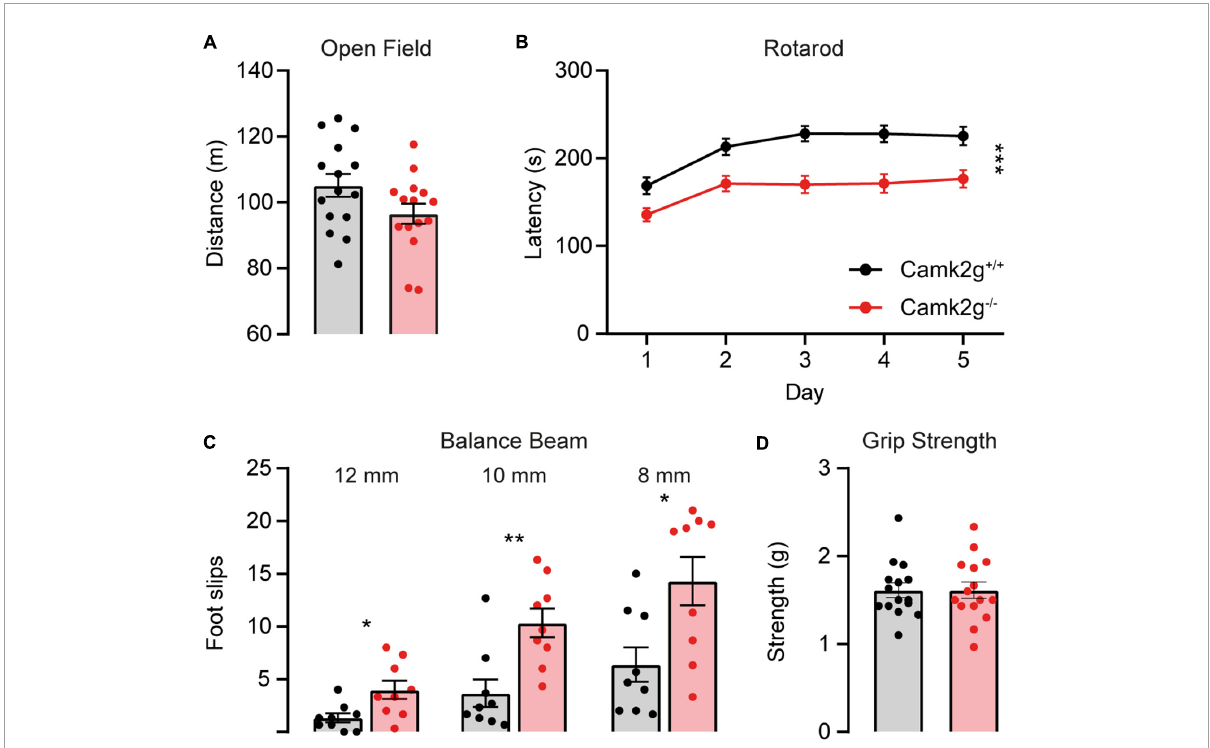
FIGURE4 CAMK2G in motor behavior. (A) No differences were found in the distance traveled in the open field [unpaired t -test, t ( 28 ) = 1.85, p = 0.076; n = 15]. (B) Camk2g − / − mice showed reduced latency to fall of the accelerating rotarod [two-way repeated measures ANOVA; interaction: F ( 4 , 352 ) = 1.51, p = 0.200; genotype: F ( 1 , 88 ) = 18.40, p < 0.001; n = 45]. (C) Camk2g − / − mice consistently slipped more often when crossing beams that were 12, 10, and 8 mm wide [unpaired t -test or Mann–Whitney U test; 12 mm: t ( 28 ) = 2.75, p = 0.014; 10 mm: U = 8.5, p = 0.003; 8 mm: t ( 28 ) = 2.81, p = 0.013; n = 9]. (D) Grip strength was unaltered between Camk2g + / + and Camk2g − / − mice [Mann–Whitney U test, U = 111, p = 0.959; n = 15]. Data represents mean ± SEM; * p < 0.05, ** p < 0.01, *** p < 0.001.